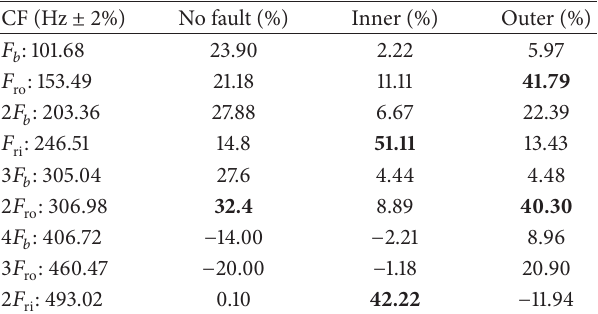
Table 3: Calculated 𝑉 Δ (𝑓 𝑖 ) s within [ 0, 500 Hz ] , 50 Hz motor input, free load condition, and radial vibration measurements.